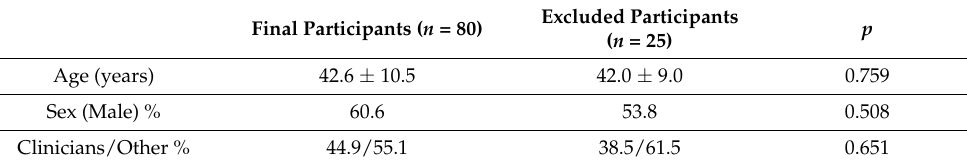
Table 2. Demographics of participants included in and excluded from the qualitative analysis (phase 2).